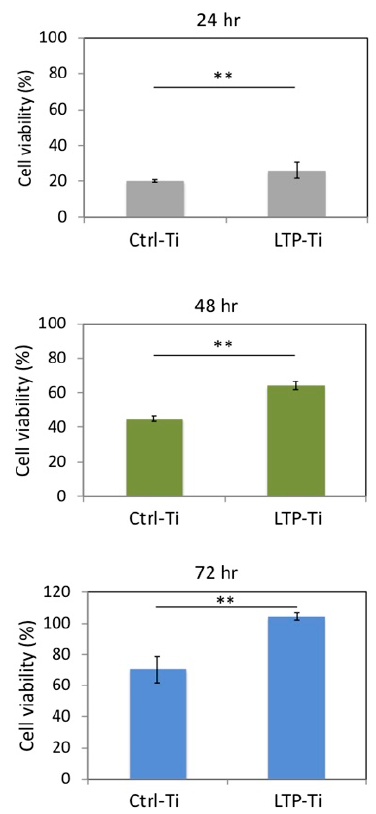
Figure 5. Viability of the MG-63 cells on treated titanium disks according to the MTT assay. Cells were harvested after 24, 48, and 72 h of culture for the MTT assay and for measuring the absorbance at 570 nm. Ctrl-Ti, control condition (autoclaving only). LTP-Ti, autoclaving followed